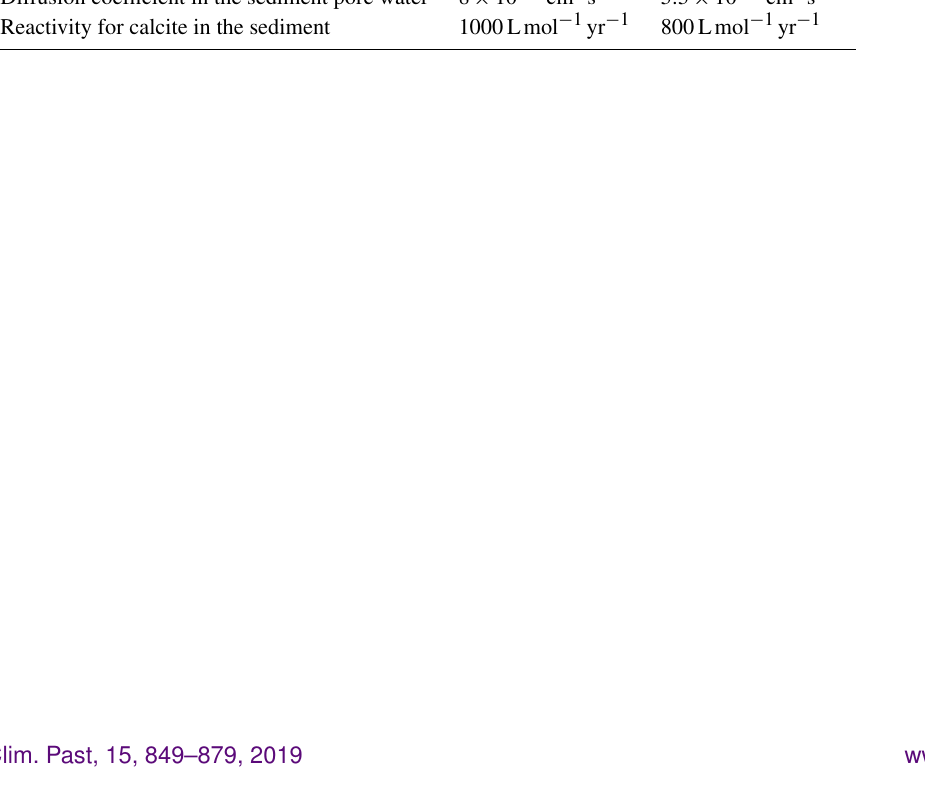
Table B1. Old and new parameter values in the Bern3D model that were varied in the tuning of the sediment component. Variable Old value New value Ratio of Ca : P in calcifiers 0.3